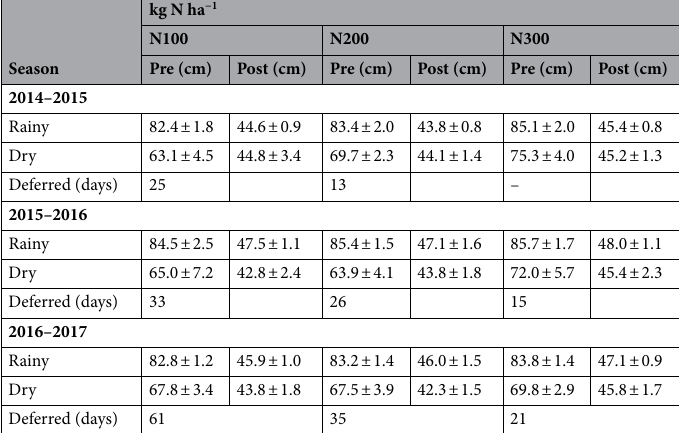
Table 2. Average and standard deviation (±) for the pre- and post-grazing sward heights of P. maximum cv. Mombaça guinea grass pastures subjected to rotational stocking and fertilized with three nitrogen levels and the period which pasture was deferred, throughout the experiment.